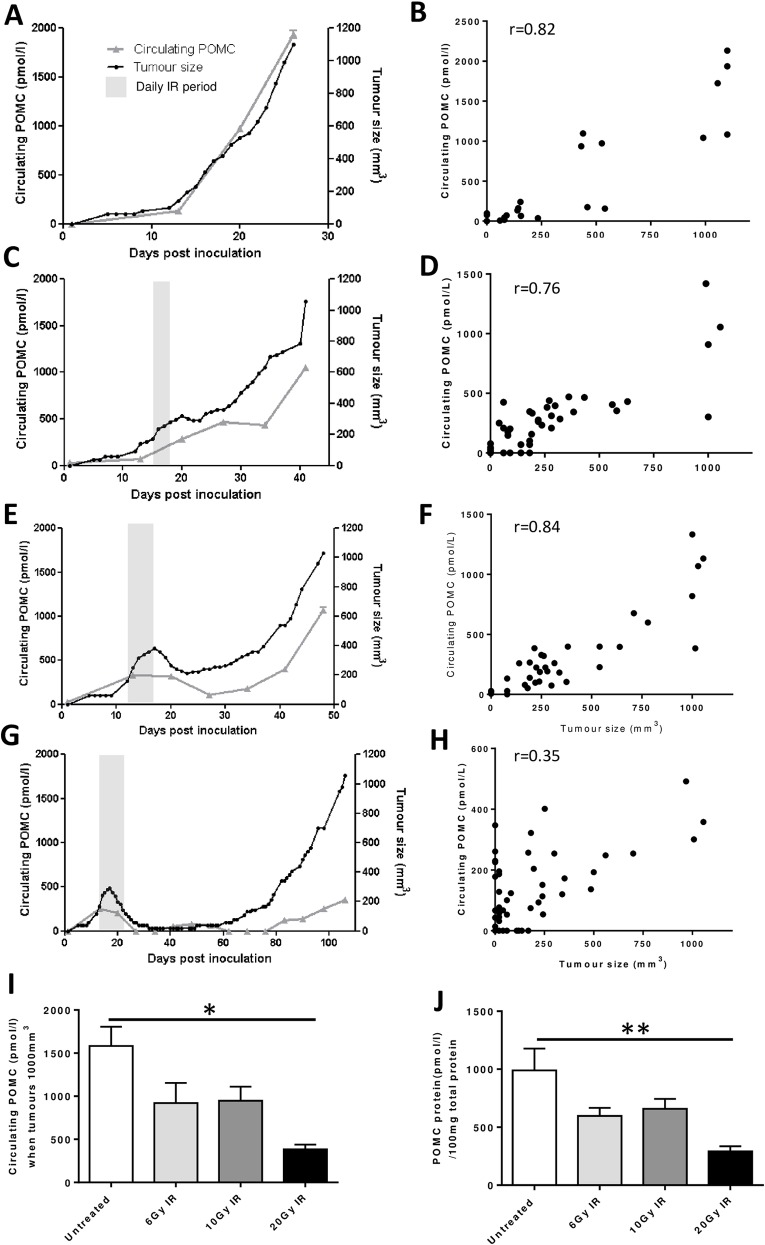
Growth of SCLC xenografts and circulating POMC in response to localised irradiation.DMS 79 cells were established as subcutaneous xenografts and once they were 200–250mm3 either left to grow untreated (A) or exposed to 2Gy IR/day for 3 consecutive days (C), 5 consecutive days (E) or 10 consecutive days (G). Circulating POMC was monitored by blood sampling on days 0, 13, 20 and every 7 days thereafter. Shaded bars indicate the period where tumours were locally exposed to IR. Circulating POMC and tumour size were analysed by correlation analysis, which was conducted on all time points from each group (B, D, F, H). Results presented (A, C, E, G) are individual mice but represent 3–5 mice/group. All individual animal data are presented in S1 Fig Circulating POMC was analysed in terminal samples (I). Whole protein from tumour samples was analysed by ELISA for POMC (J). The following numbers of animals reached 1000mm3 tumour volume within 120 days from tumour implant; Untreated group 5/5, 3x2Gy 4/5, 5x2Gy 5/5, 10x2Gy 3/4 *p = <0.05 **p = <0.01. Controls in Fig 1A have originally been described in Stovold et al. British Journal of Cancer [10].